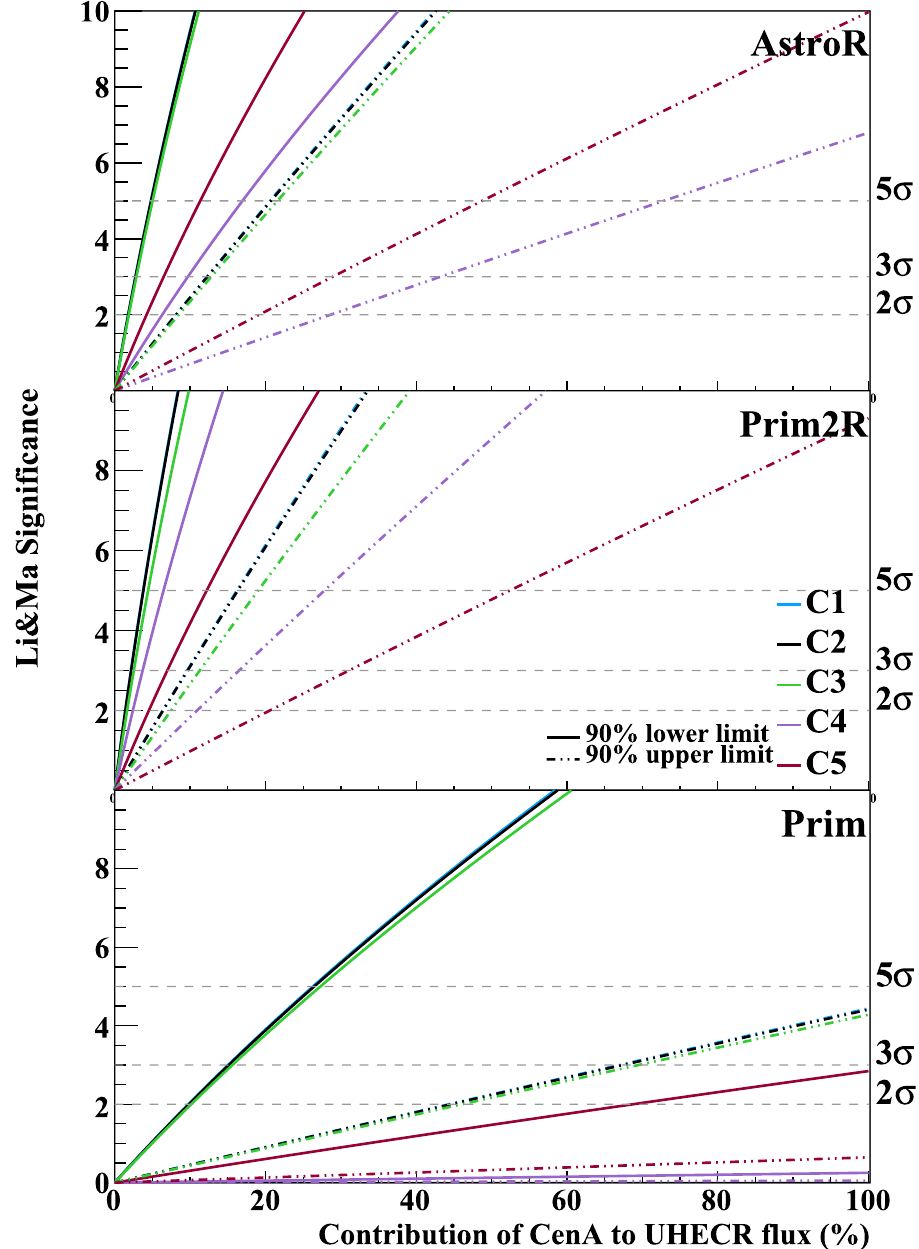
Fig. 12 Li-Ma significance of the photon signal as a function of the contribution from Cen A to the total UHECR flux measured by the Pierre Auger Observatory for energies above 60 EeV. The significance was calculated supposing 80,000 m 2 detection area observatory taking data during five years. Full (dashed-dotted) lines represents the calculations when the 90% lower (upper) limit flux of cosmogenic background photons estimated in reference [23] was considered as the null hypothesis. The three EGMF models (AstroR, Prim2R and Prim) and five composition abundance (C1–C5) are